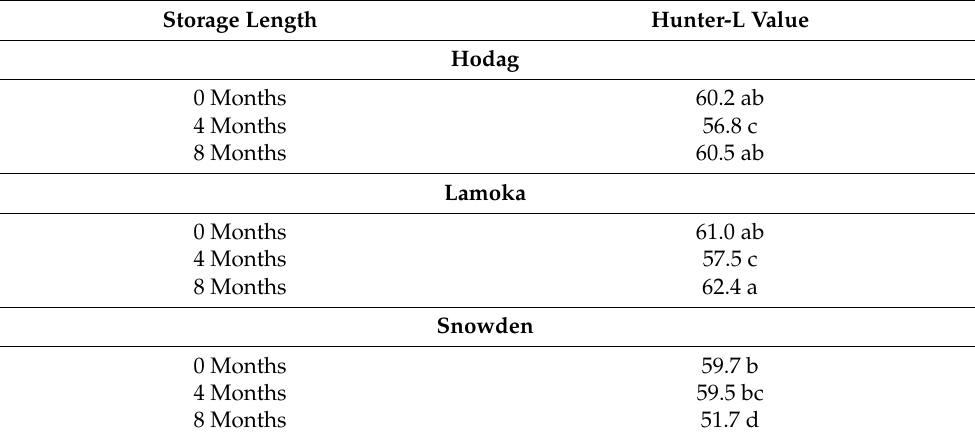
Table 10. Chip fry color, indicated by Hunter-L values, in 2019 that was significantly influenced by the interaction between variety and storage length. Numbers followed by different letters are significantly different at α =